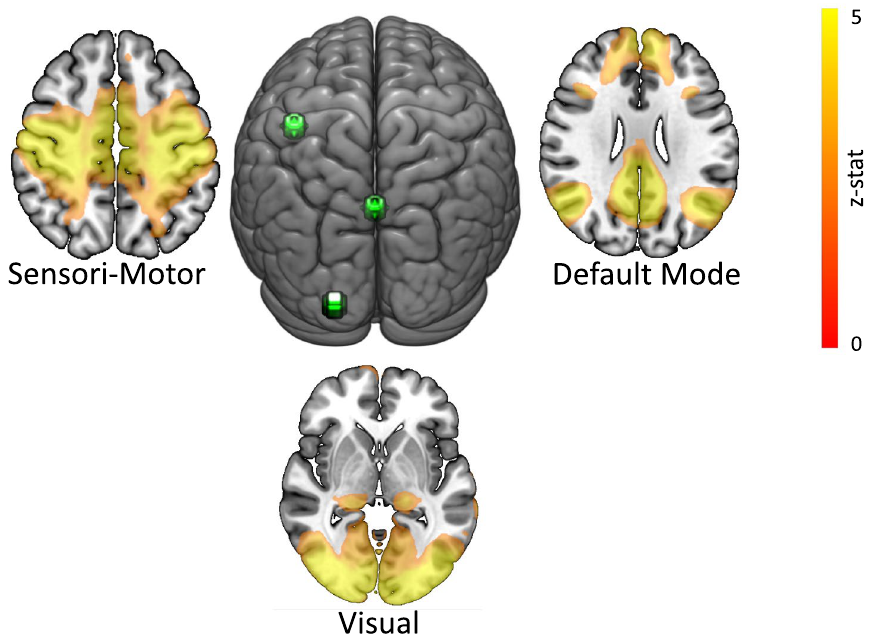
Figure 2. Functional connectivity and resting-state networks at 15–20 min after sham tSMS stimulation, block without tSMS effect. The three functional connectivity networks [Sensori-Motor Network (SMN), Default Mode Network (DMN) and Visual Network (VN)] are displayed along with the corresponding seed locations (left-M1: − 40, − 18, 48, PCC: 0, − 54, 26 and left-V1: − 20, − 100, 4) that were used to define the networks with the seed- based connectivity analysis